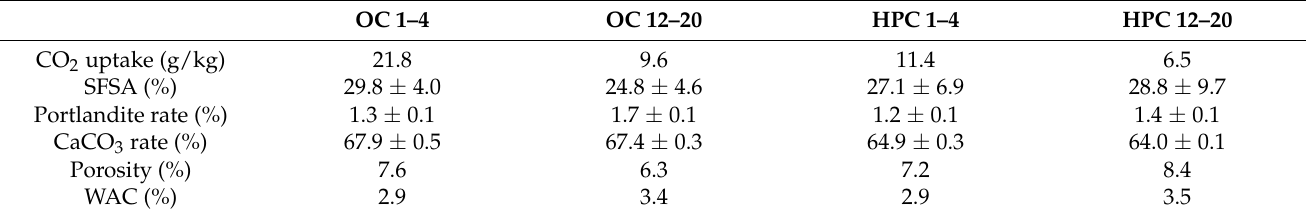
Table 6. Properties of carbonated RCAs (RCAs from laboratory concretes).